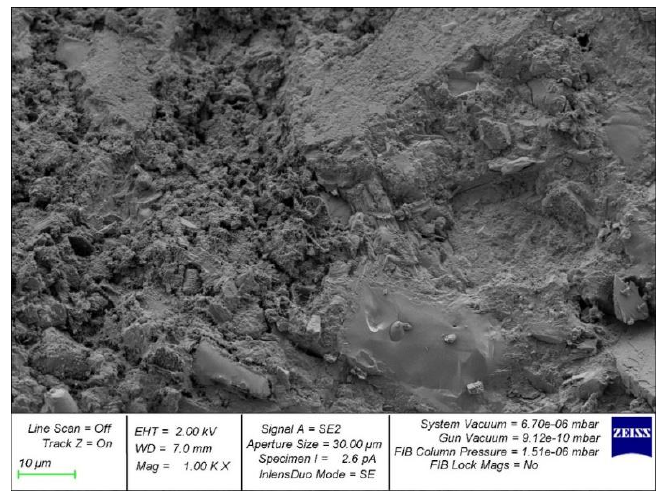
Appl. Sci. 2022 , 12 , 6606 Figure 10. Sample with partial replacement of cement with eggshell powder at 10%.